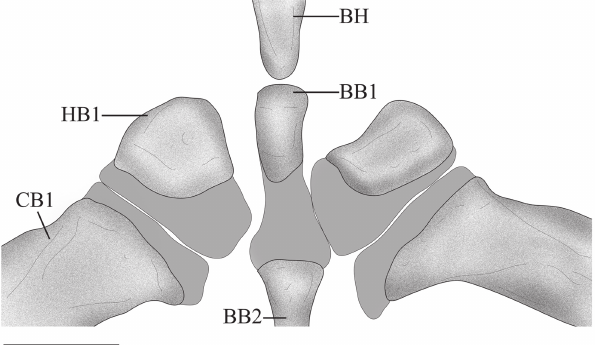
Fig. 2. Dorsal view of anterior portion of gill arches of Eigenmannia sayona (MZUSP 119711, paratype, 90 mm LEA). BH= basihyal; BB1= basibranchial 1; BB2= basibranchial 2; HB1= hypobranchial 1; CB1= ceratobranchial 1. Cartilage represented by gray coloration. Scale bar: 0.5 mm.